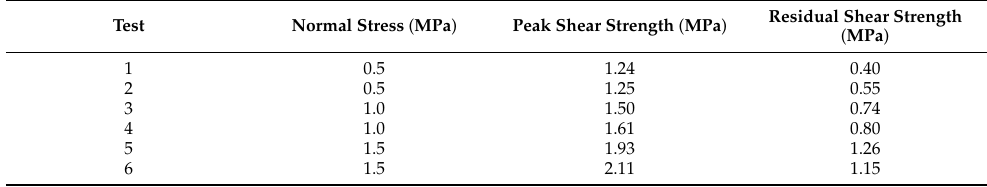
Table 3. Summary of the results of direct shear tests of bush-hammered interfaces.